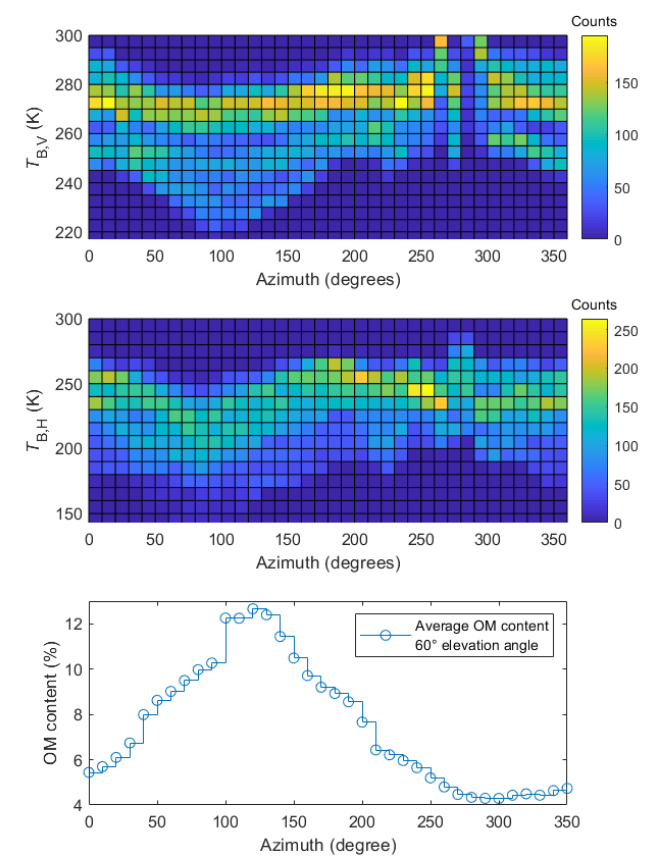
Figure 6. Bivariate histograms of T B,V and T B,H time-series values vs. the azimuth angle for the analyzed period. The bottom figure shows a distribution of averaged (within the footprint area) OM content for elevation angle 60°.